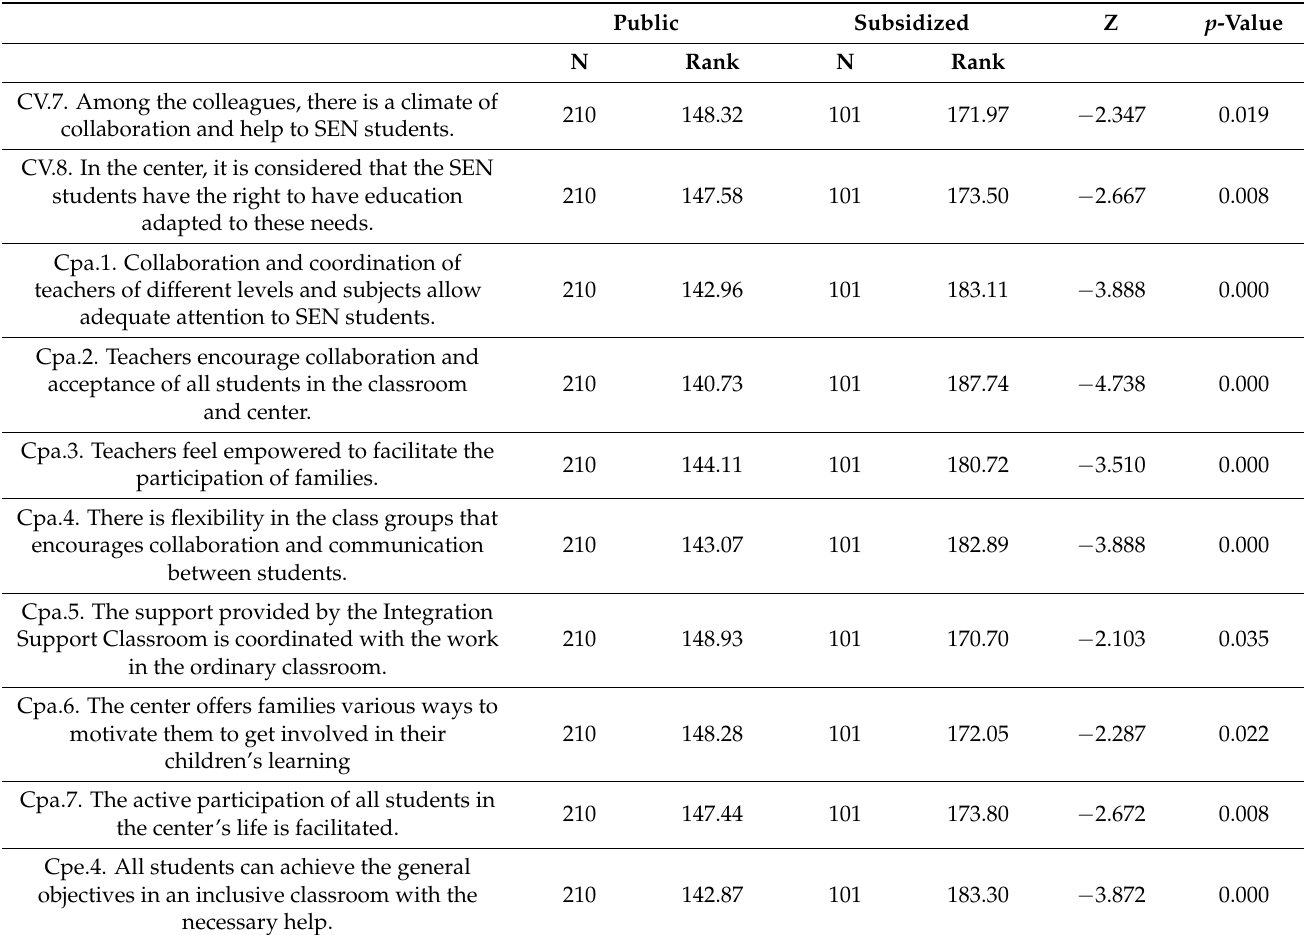
Table 9. Cont. Public Subsidized Z p